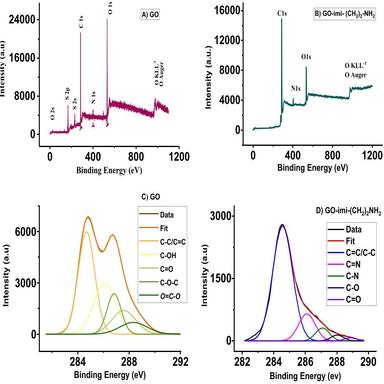
XPS spectra and its deconvolution for graphene oxide (A and C) and for GO- imi- (CH2)4-NH2 (B and D), respectively.